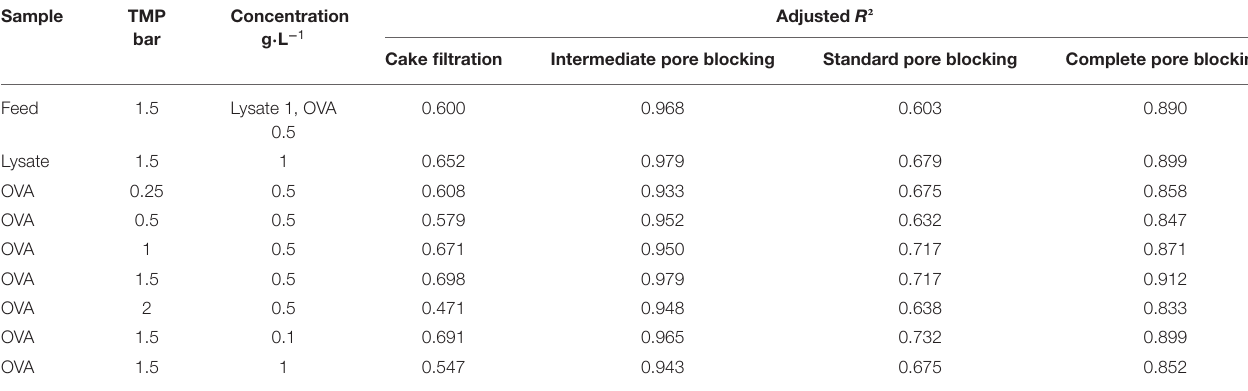
TABLE 4 | Adjusted R ² -values of fouling models for the cross-flow filtration data. Sample